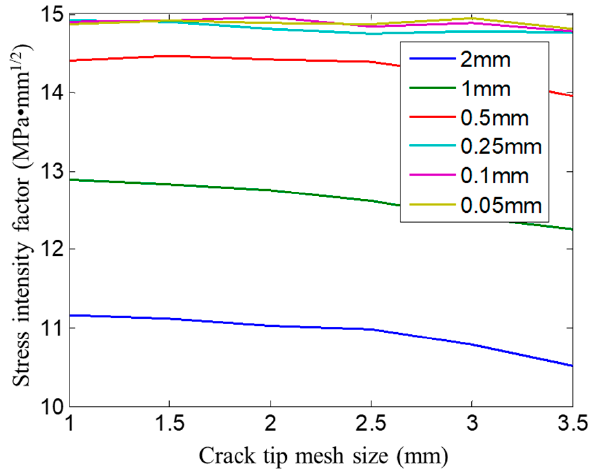
Figure 3. Effect of crack tip mesh size on stress intensity factor.